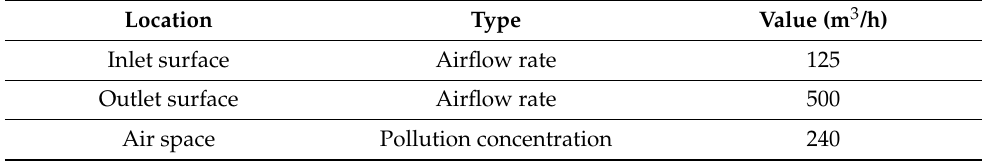
Figure 5. ( a ) 3D model of the tested apartment; ( b ) mesh of the computational domain. Table 1. Boundary conditions of the computational